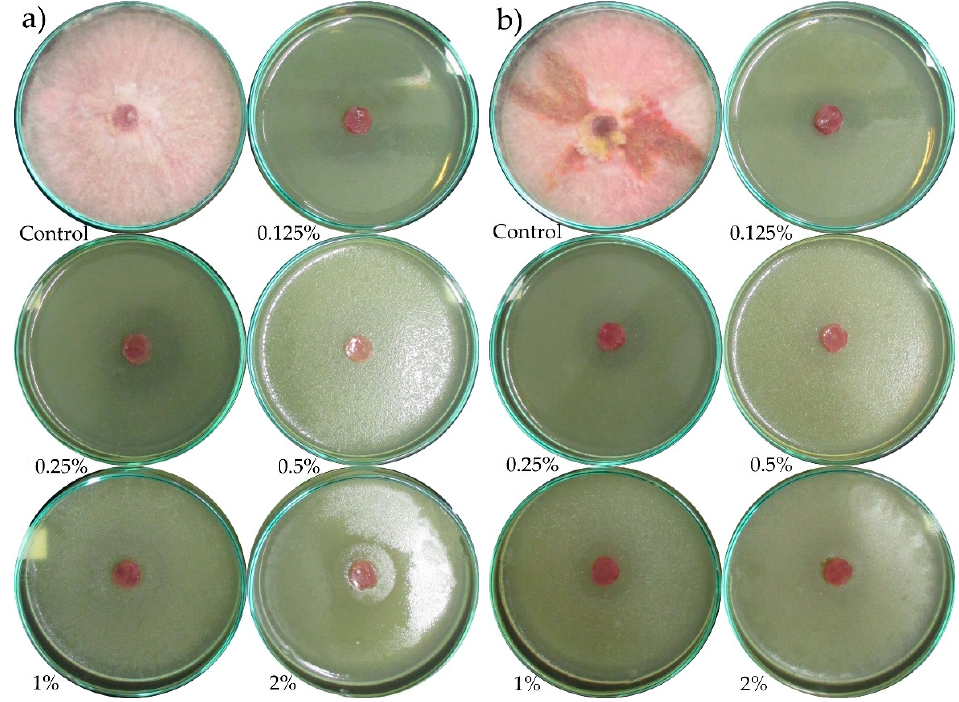
Figure A6. The effect of rosewood oil concentrations on the growth of Fusarium graminearum ZALF 24 ( a ) and Fusarium graminearum ZALF 339 ( b ).